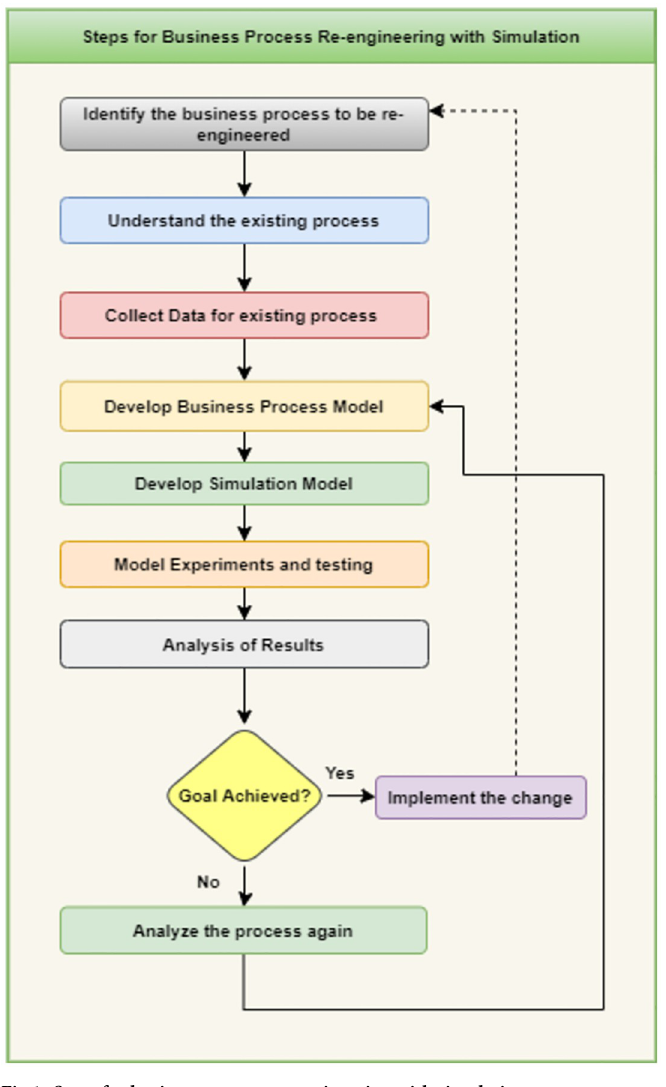
Fig 1. Steps for business process re-engineering with